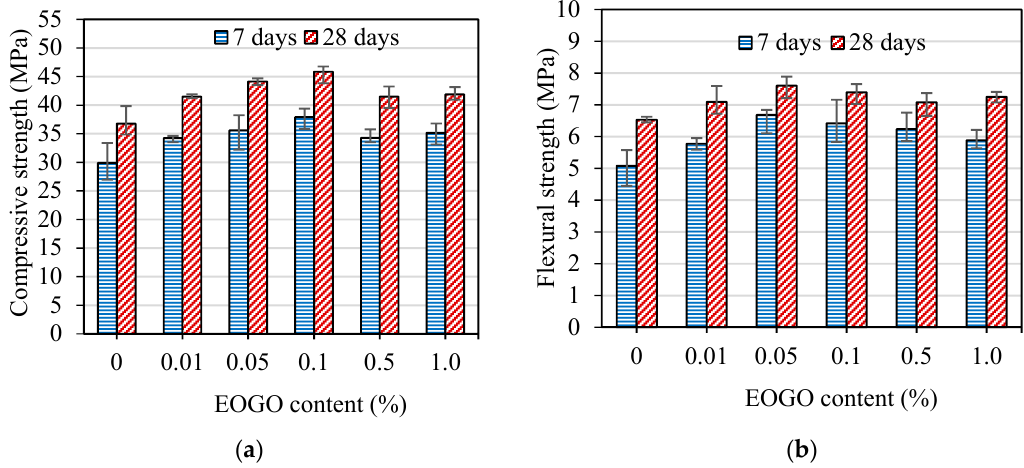
Figure 8. ( a ) Compressive strength and ( b ) flexural strength of EOGO-mortars with the wet-mix design method.